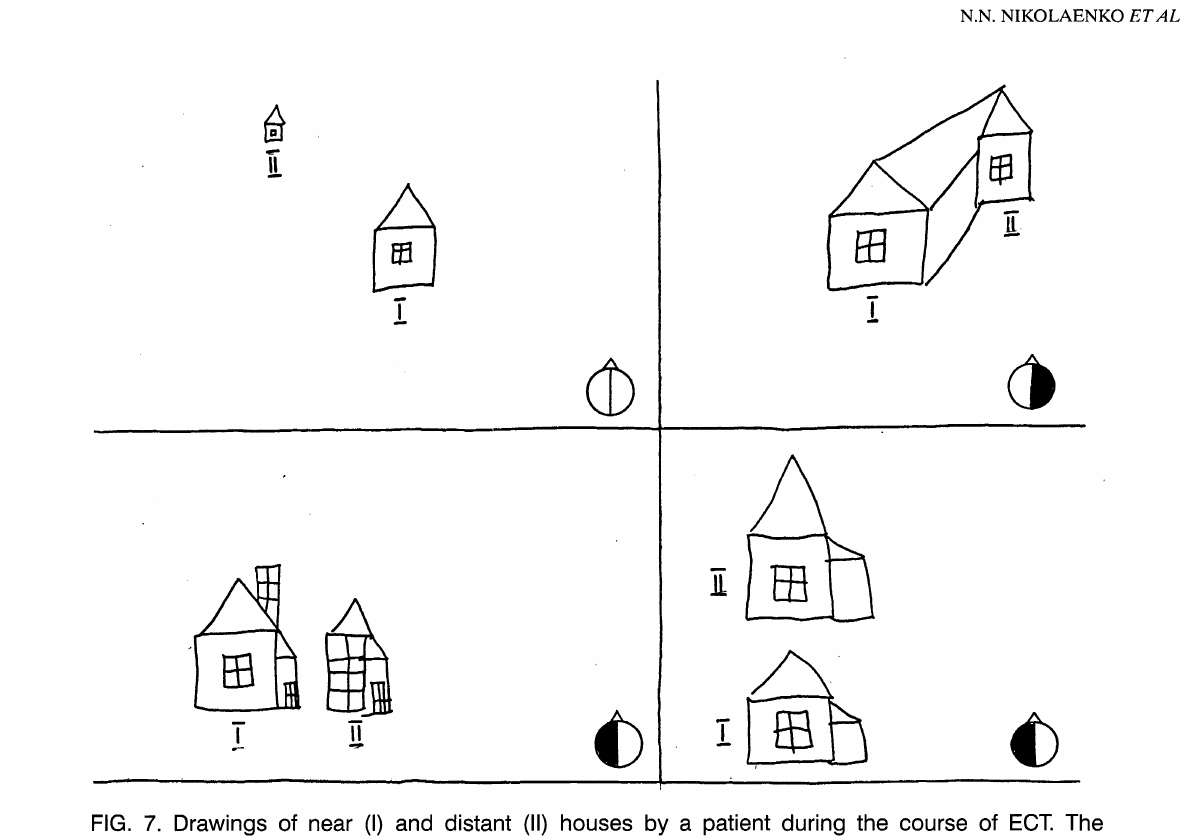
FIG. 7. Drawings of near (I) and distant (II) houses by a patient during the course of ECT. The suppressed hemisphere is shaded.